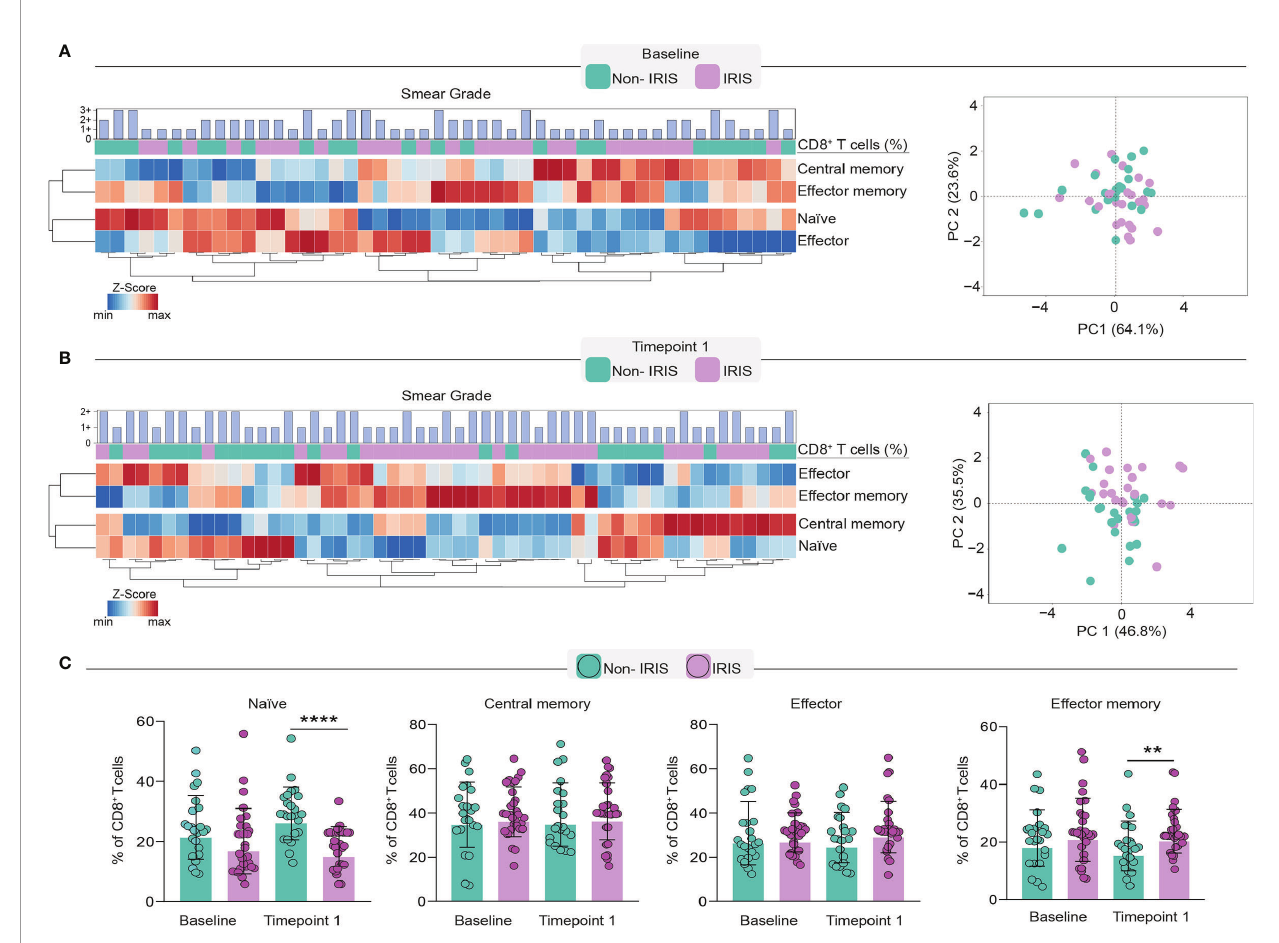
FIGURE 2 | Evaluation of CD8 + T cell memory subsets in TB-IRIS pathogenesis. In order to dissect the memory subset of CD8 + T cells, we employed a heatmap coupled with hierarchical cluster analysis (Ward ’ s method) and principal component analysis at baseline (A) and timepoint 1 (B) . Principal component analysis was performed considering the frequencies of CD8 + T cell memory subsets at the aforementioned time points. Scatterplots depict the frequencies of each memory subset within total CD8 + T cell counts. (C) Comparison of frequencies of memory subsets in TB-IRIS and Non-IRIS patients. Data were analyzed using the Mann- Whitney test or Wilcoxon matched-pairs test for paired analyses within each study group (**p < 0.01, ****p <